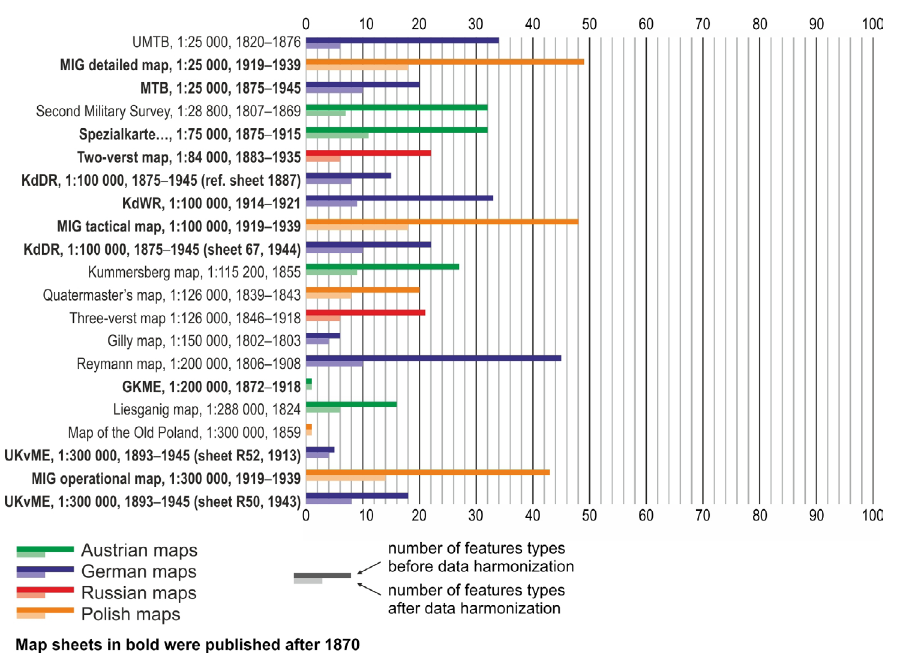
Fig. 6. Number of feature types on different maps’ key to symbols among “land use” feature class category (before and after